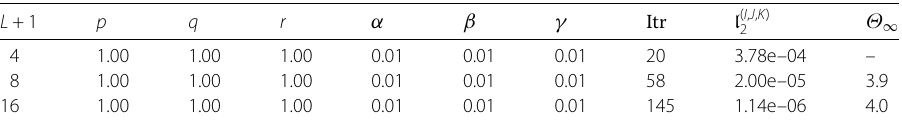
Table 4a Errors and computational rate for the UM-FOCS in Example 5.4 L + 1